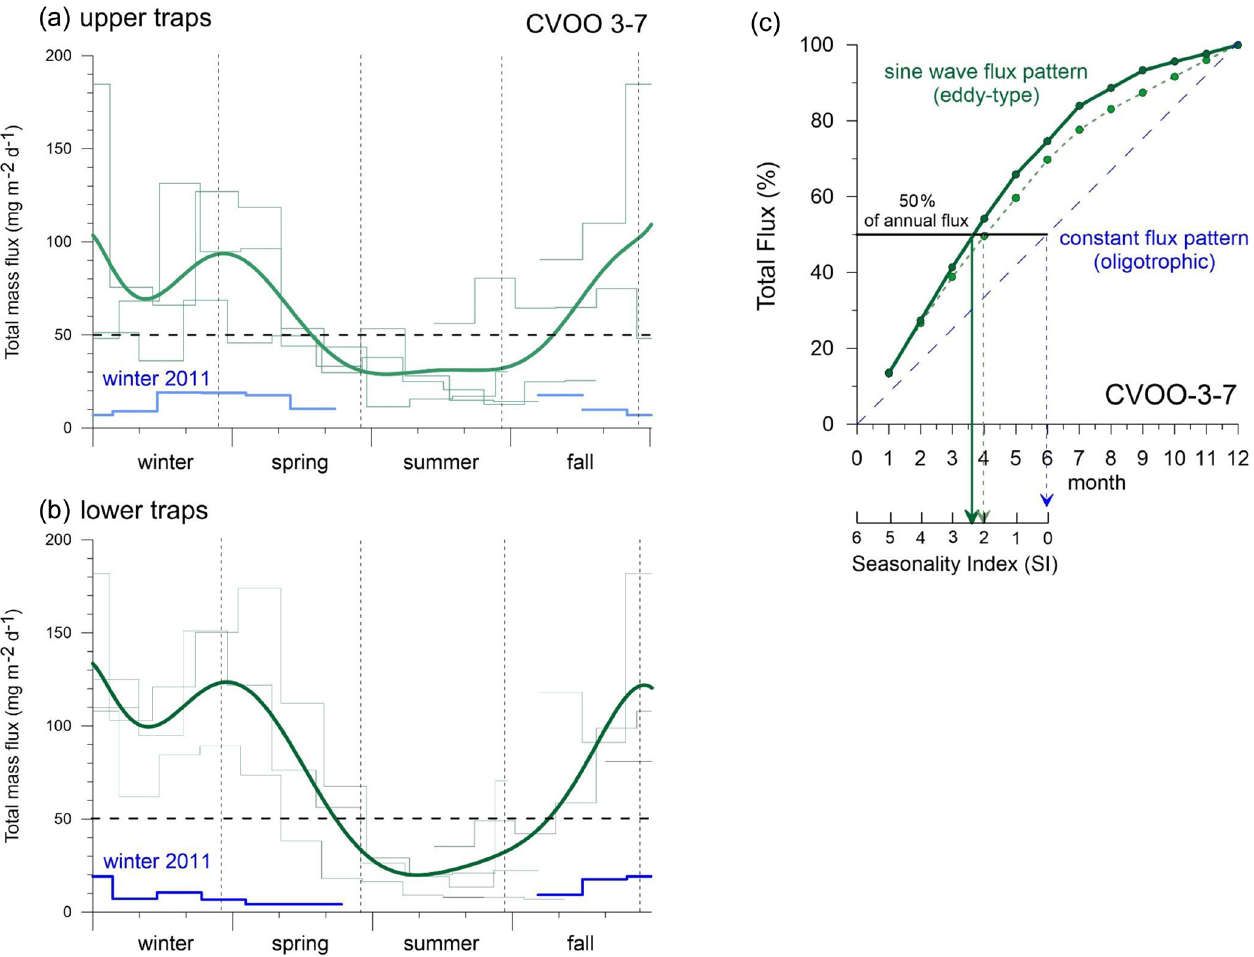
Figure 8. Seasonal total flux patterns for the upper (a) and lower (b) traps characteristic of different types of eddies (light and dark green, 9-order polynomial fit) vs. oligotrophic conditions during winter 2011 (blue indicates oligotrophic background with more or less constant flux/productivity pattern and low seasonality, SI index of 0–1 in c ) at CVOO. Dashed horizontal line: typical oligotrophic background fluxes (ca. 50mgm − 2 d − 1 ) in the North Atlantic gyre (see text). (c) Sum of total particle fluxes and seasonality index (SI; Berger and Wefer, 1990) for the upper (dashed light green) and lower (dark green) traps taken from the means in (a) and (b) . The SI is defined as 6 minus the production half-time in months (Berger and Wefer, 1990). Note the overall higher seasonality (sine wave production) in the lower traps (SI is ca. 2.4 (i.e., 6 − 3 . 6)) compared to the upper traps (SI is ca. 2.0 (i.e., 6 − 4)) during eddy passages (2010, 2012, 2016). For comparison, a constant flux pattern, typical of oligotrophic settings, is shown schematically in (b)